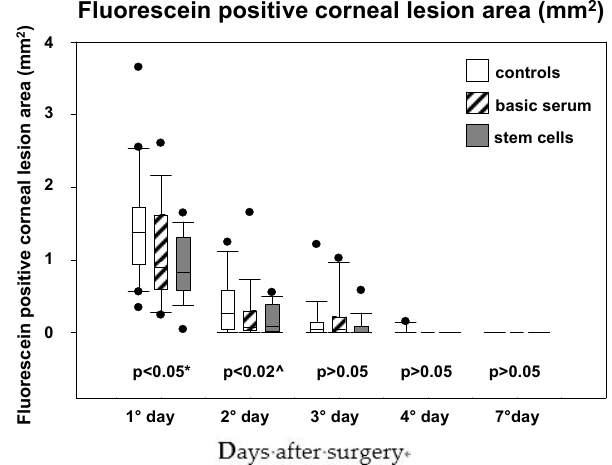
Figure 2. Box plots of median epithelium defect area over time at each time point for each treatment group in the mice eyes. * = statistically significant difference between stem cells and control groups; ^ = statistically significant difference between controls and the other groups.